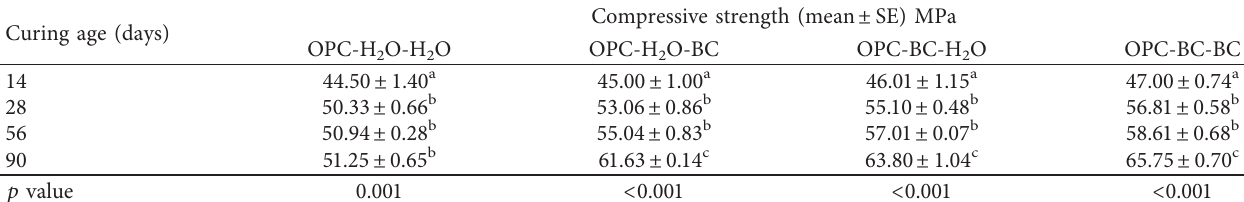
Table 3: Results of comparison of compressive strength development of mortar with curing age.